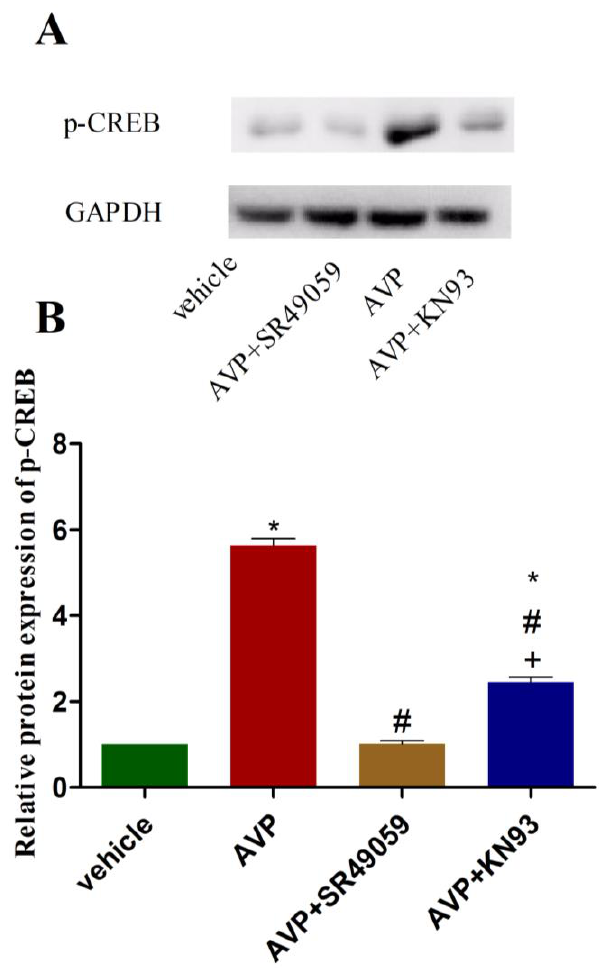
Figure 5. Effects of AVP on p-CREB expression in CMECs. p-CREB, phosphorylated CREB; AVP, 10 −7 mol/L; SR49059, 10 −6 mol /L; KN93, 10 −6 mol /L. ( A ) Representative images of Western blots. ( B ) Graphical representation of protein expression of p-CREB. * p < 0.05 vs. vehicle; # p < 0.05 vs. AVP; + p < 0.05 vs. (AVP + SR49059).